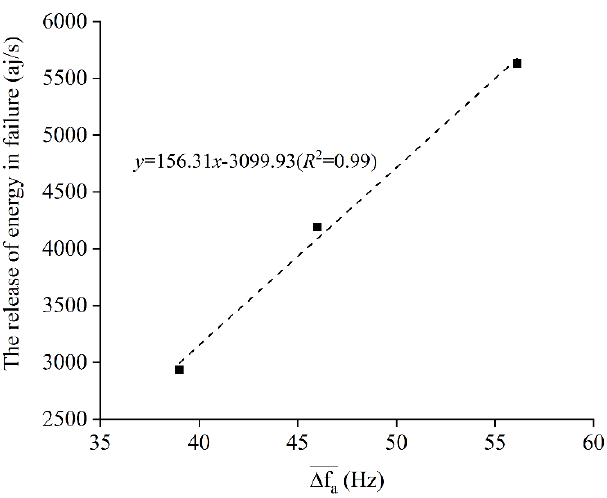
Figure 22. Relationship between the release of energy during failure and ∆𝑓 (cid:3028) (cid:3364)(cid:3364)(cid:3364)(cid:3364)(cid:3364)